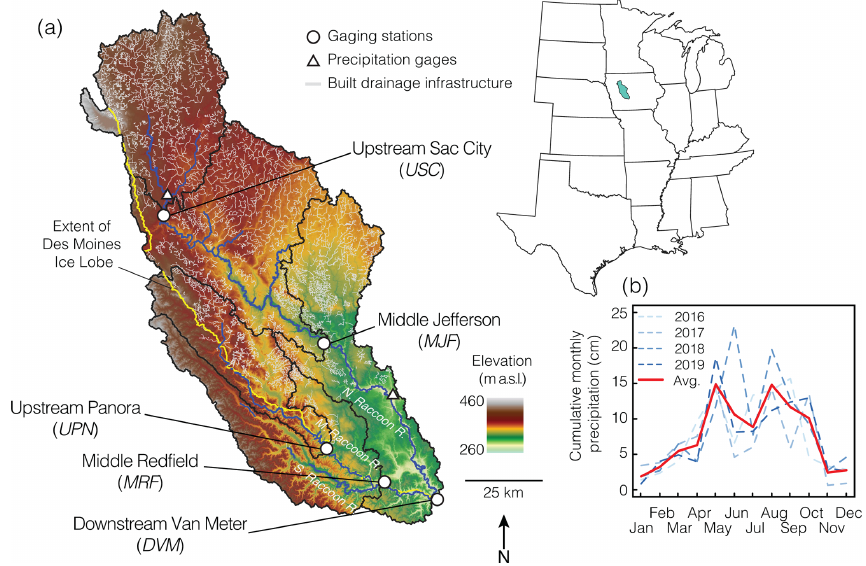
Figure 1. (a) Map of five watersheds (black outlines) analyzed in central Iowa along the North, Middle, and South Raccoon rivers. Middle Jefferson (MJF) is inclusive of Upstream Sac City (USC), Middle Redfield (MRF) is inclusive of Upstream Panora (UPN), and Downstream Van Meter (DVM) is inclusive of the entire watershed pictured. The yellow line maps the extent of the Des Moines Lobe in the last glaciation. Areas to the southwest of the line lie in the southern Iowa drift plain. Built drainage infrastructure is shown in gray. Gaging stations (white circles) are along the North and Middle Raccoon rivers (blue lines), and the DVM gaging station is below the confluence of the branches of the Raccoon rivers. A total of two precipitation gages are shown with white triangles. Precipitation data were averaged on a monthly basis across the 4-year study period (2016–2019) and shown in (b) ; the red line indicates the monthly averages across the 4 years. Landform and drainage infrastructure data were downloaded from the Iowa Department of Natural